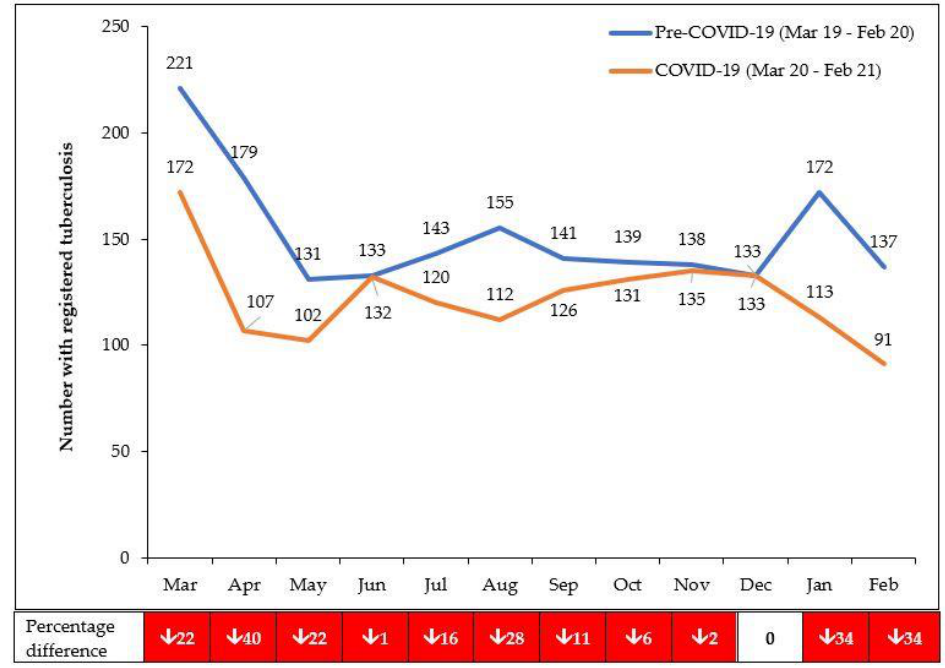
Figure 3. Numbers presenting each month with registered TB in eight health facilities in Lilongwe, Malawi, during the pre-COVID-19 and COVID-19 periods. From October 2020 onwards, health workers were asked to pro-actively ask about symptoms of TB in those attending outpatient departments; there was an active tracing of patients needing to be registered.